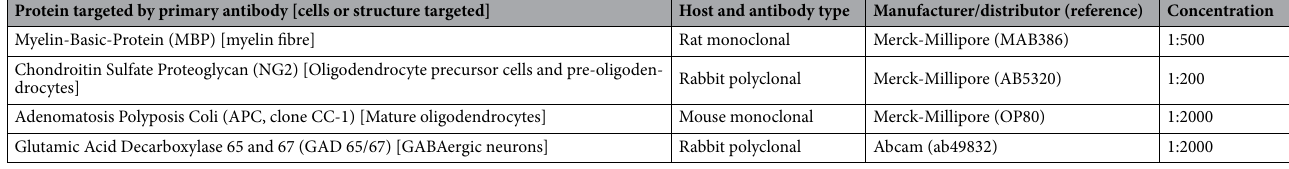
Table 1. Primary